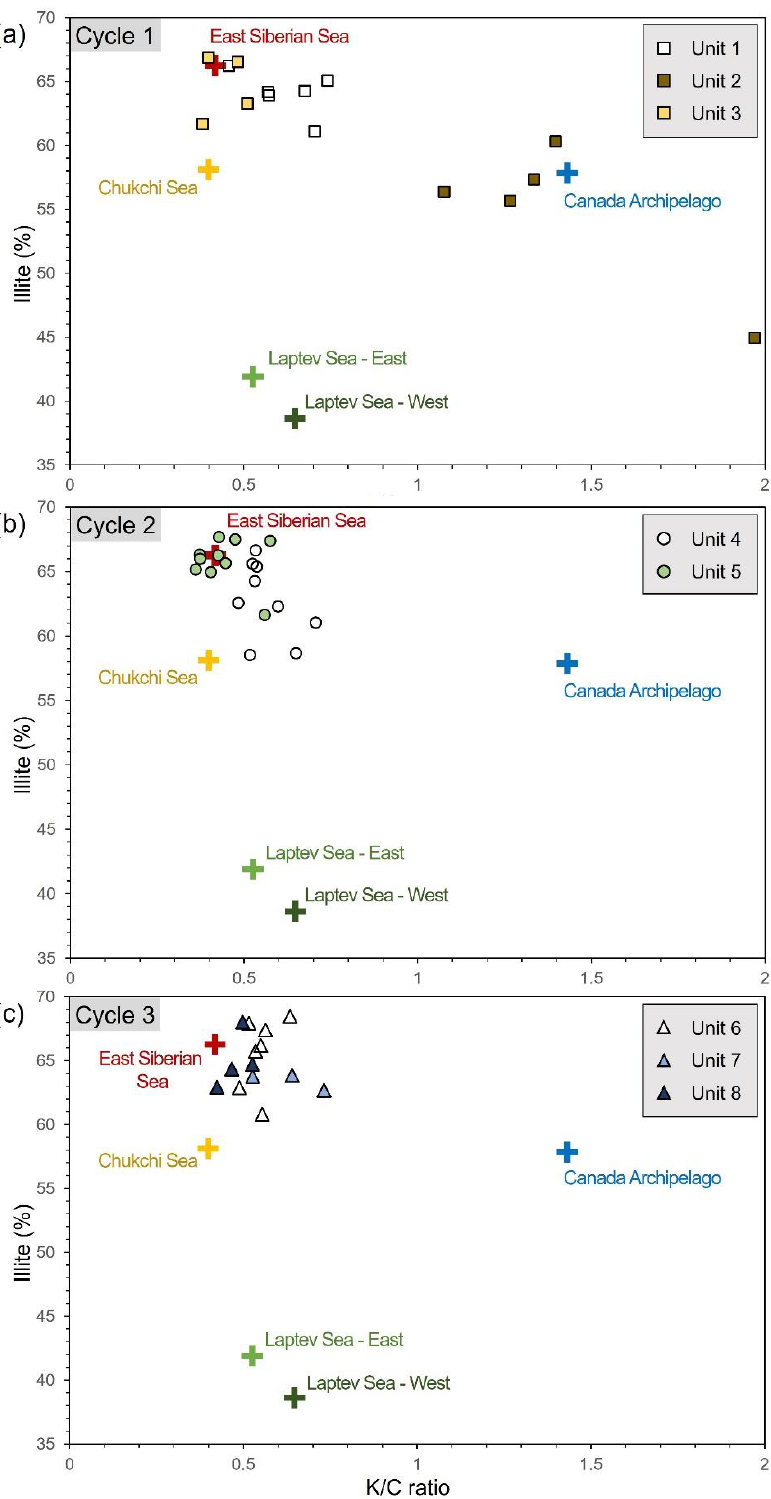
Figure 5. Discrimination plots showing variations in K/C ratio vs. illite during ( a ) Cycle 1, ( b ) Cycle 2, and ( c ) Cycle 3. Clay mineralogical data of potential provenances are also shown for comparisons [18,19]. K/C: kaolinite/chlorite. Units 3, 5, and 8 likely correspond to the glacial/stadial sediments in core ARA09C- St03 (Figure 2). During the glacial periods, when the sea level was low, the Arctic